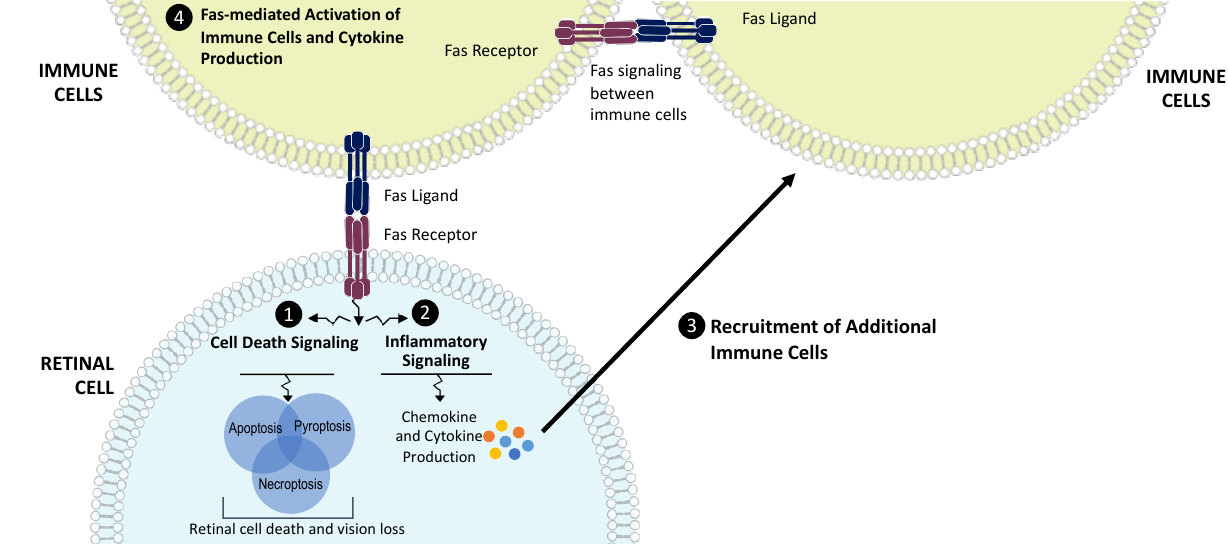
Figure 1. Fas as a regulator of cell death and inflammation in AMD. Disease stress leads to Fas activation in retinal cells and induces Fas signaling, which triggers ( 1 ) cell death signaling cascades and ( 2 ) production of cytokines and chemokines through the activation of inflammatory pathways. These molecules contribute to the inflammatory microenvironment and ( 3 ) recruit additional immune cells that bring more Fas ligand to the retina. These recruited immune cells also ( 4 ) activate nearby immune cells, leading to the production of additional inflammatory cytokines. This amplifies and propagates the inflammatory microenvironment and the cycle of retinal cell death and vision